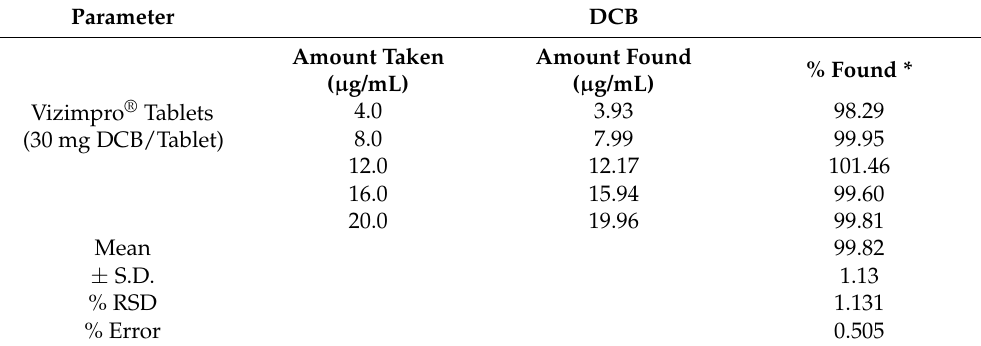
Table 5. Determination of DCB in Vizimpro ® tablets by the proposed spectrofluorimetric method.